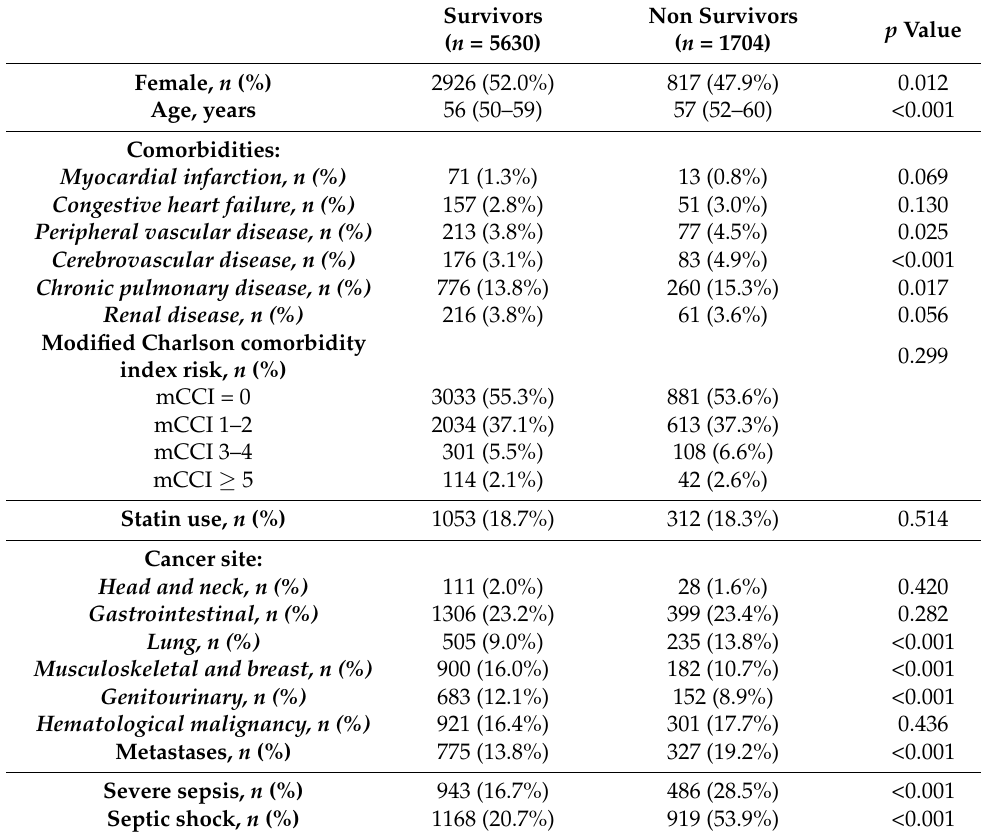
Table 4. Comparison between hospital survivors and non-survivors among cancer patients hospital- ized with sepsis during